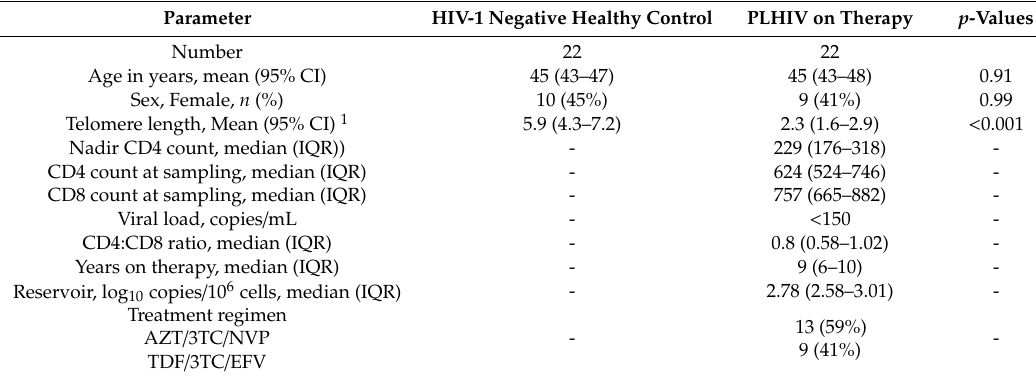
Table 1. Participant clinical and demographic